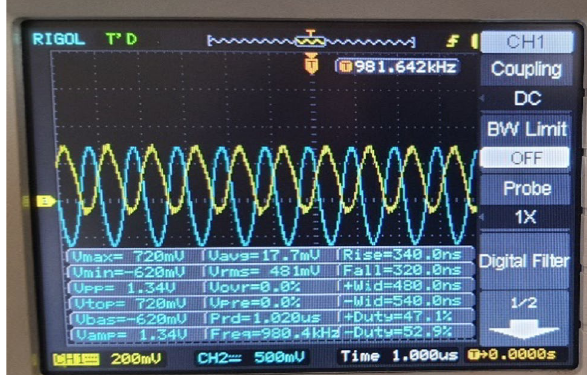
Fig. 7 Gain at 980 kHz showing expected frequency response from